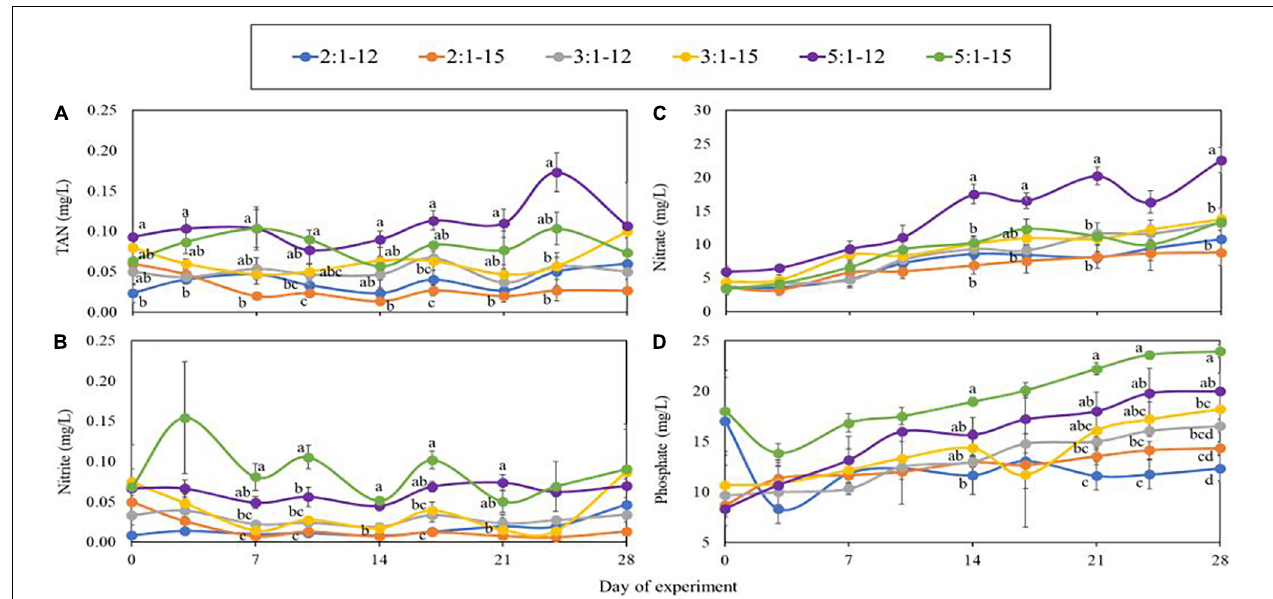
FIGURE 3 | Concentrations of TAN (A) , nitrite (B) , nitrate (C) , and phosphate (D) measured during the 4-week experiment. Each point represents the means of 3 replicates ± standard error. Lower-case alphabet letters represent significant differences, followed by one-way ANOVA and Tukey’s HSD test ( α =